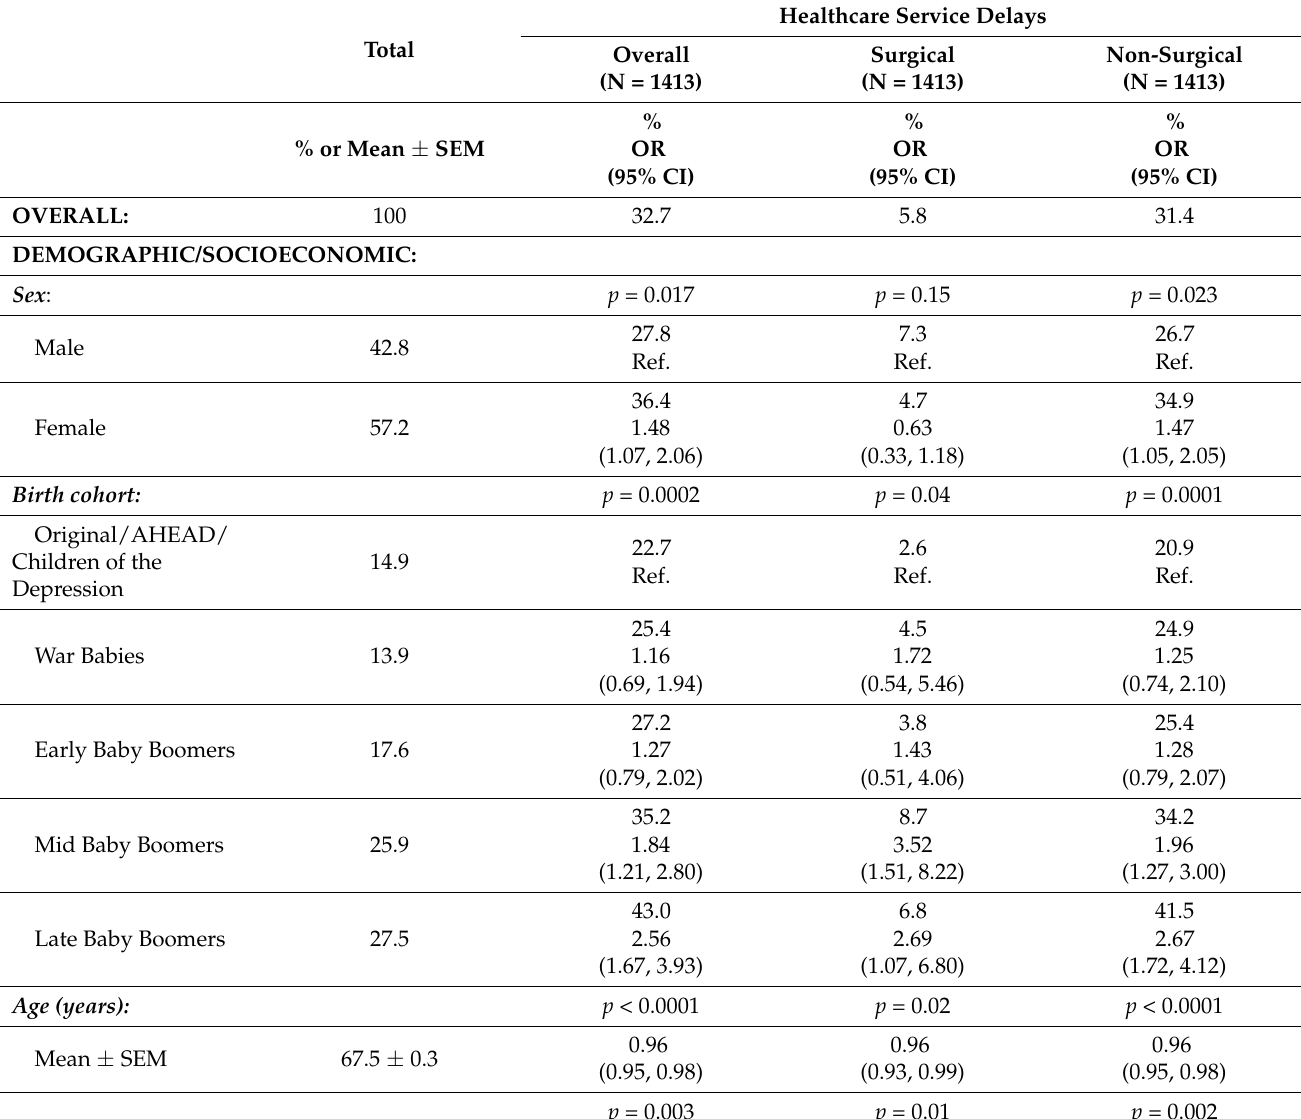
Baseline characteristics by healthcare service delays–HRS COVID-19 half-sample (N = 1413) a